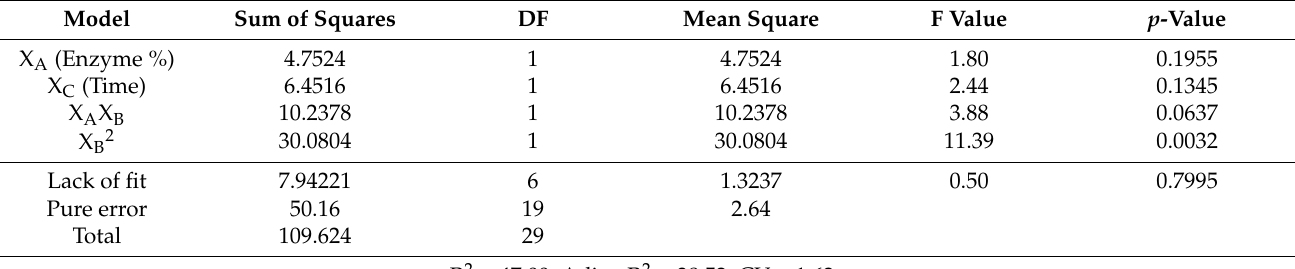
Lack of fit 7.94221 6